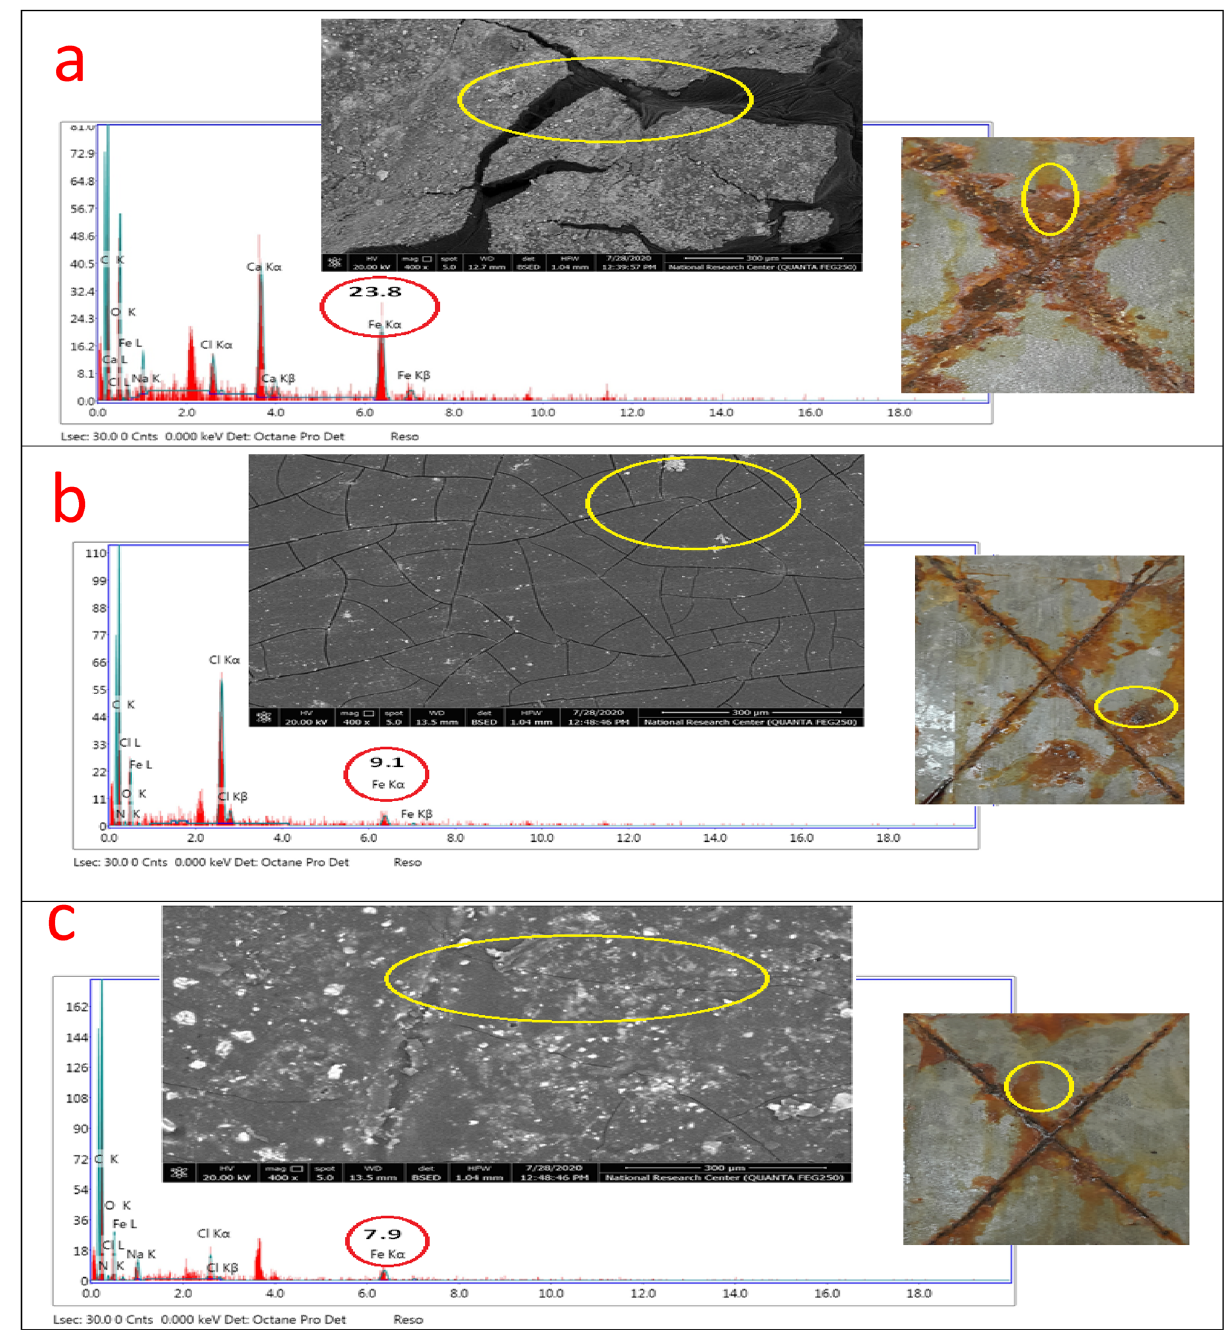
Figure 7. EDX/SEM image collections of the investigated coated films ( a ) Unmodified conventional epoxy, ( b ) PA-DGEBA/MF, ( c ) PA-DGEBA/Bipy, ( d ) PA-DGEBA/MC-Zr and ( e ) PA-DGEBA/MC-Cu after the direct exposure to salt spray fog at severe